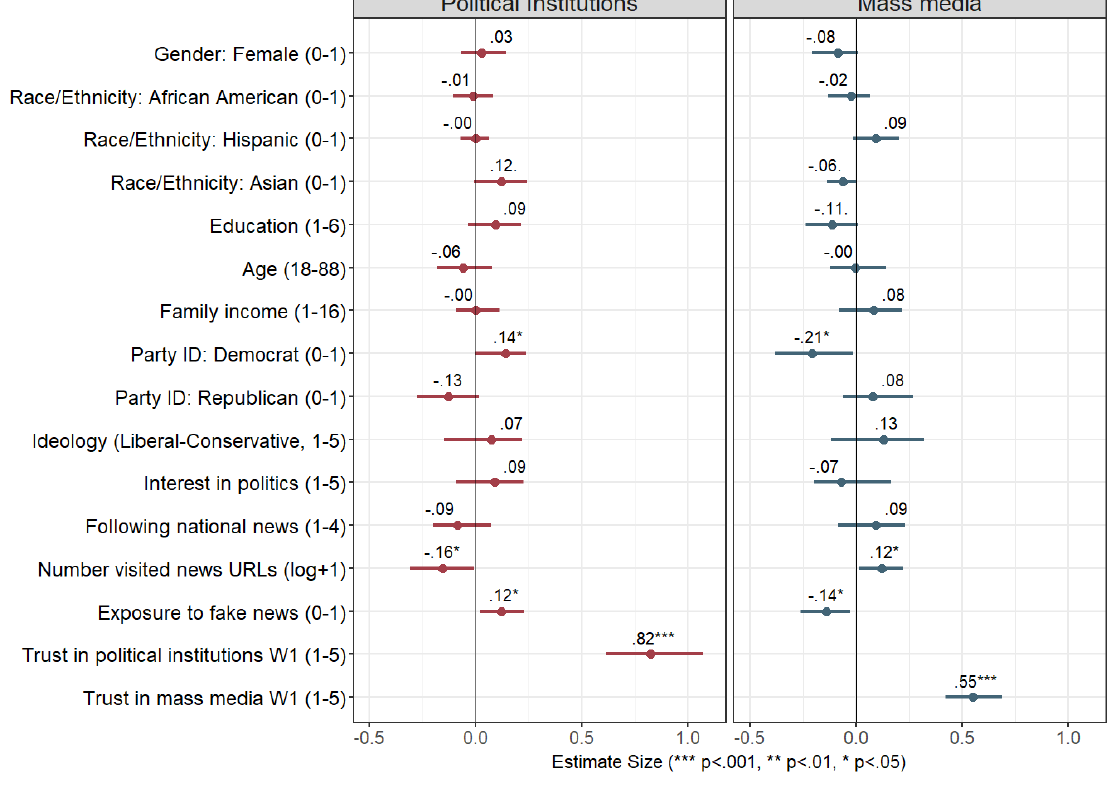
Figure 1. Trust in politics and mass media. The figure shows standardized coefficients from ordinary least squares regressions predicting political trust (on the left) and media trust (on the right). Variables whose error bars are to the right (left) of the zero line are positively (negatively) associated with the